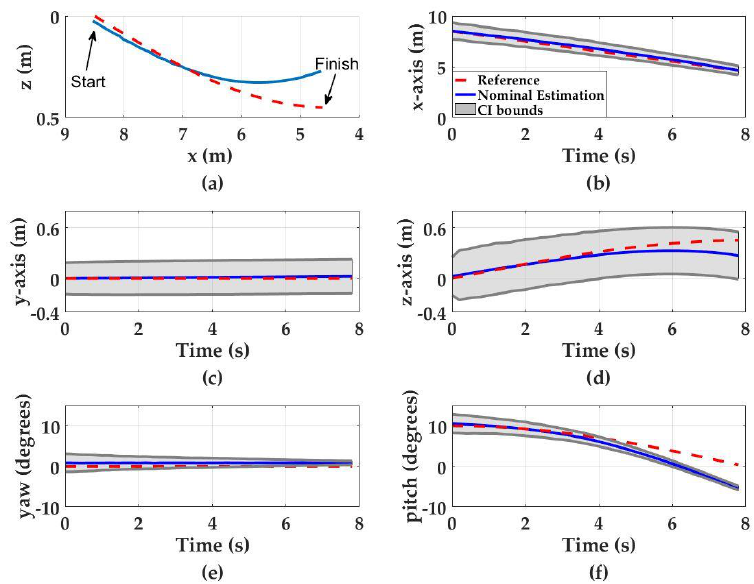
Figure 6. Monte Carlo simulation results when UUV undergoes diving motion. Red dashed curves denote the UUV motion, blue curves denote the nominal position estimations and the gray regions denote the 95% CI. ( a ) The UUV trajectory in diving motion; ( b ) x -axis estimations; ( c ) y -axis estimations; ( d ) z -axis estimations; ( e ) yaw estimations; and ( f ) pitch estimations. The CI bounds for both the y - and z -axis slightly increase as the UUV approaches the light source from ±0.18 m at the beginning of the motion to approximately ±0.2 m at the end of the motion for y -axis and ±0.22 m to ±0.28 m for z -axis. This is likely caused by the propagation of uncertainty in x -, pitch and yaw estimations, which are used to update the y - and z -axis estimations. 3.1.2. Three-Dimensional Zigzag Motion in Clear Waters ( 𝐾 𝐷 = 0.09 m −1 ) The simulated navigation results of a UUV in 3-D zigzag motion are shown in Figure 7. The final nominal translational estimation errors (i.e., ensemble average of all the estimations for Ns = 2000) for the x -, y - and z -axis are 0.13 m, 0.13 m, and 0.05 m, respectively. The final nominal orientation estimation errors for pitch and yaw are 3° and 4°, respectively. The uncertainty values throughout the motion demonstrate a similar pattern to the diving motion. The estimation uncertainties